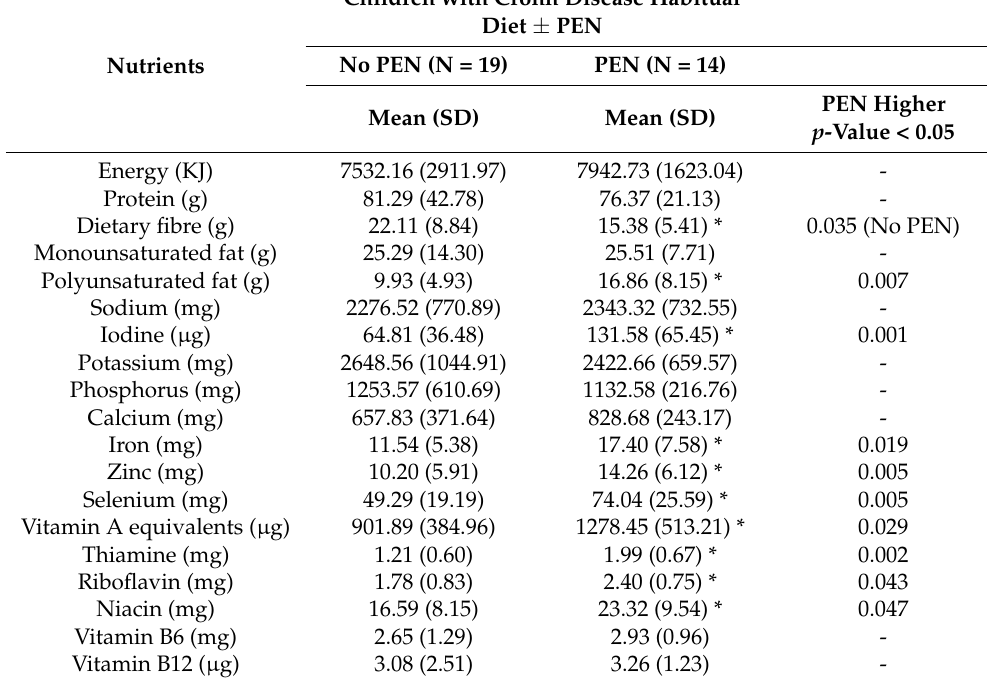
Table 3. Dietary intake of children with Crohn’s disease who consumed and did not consume